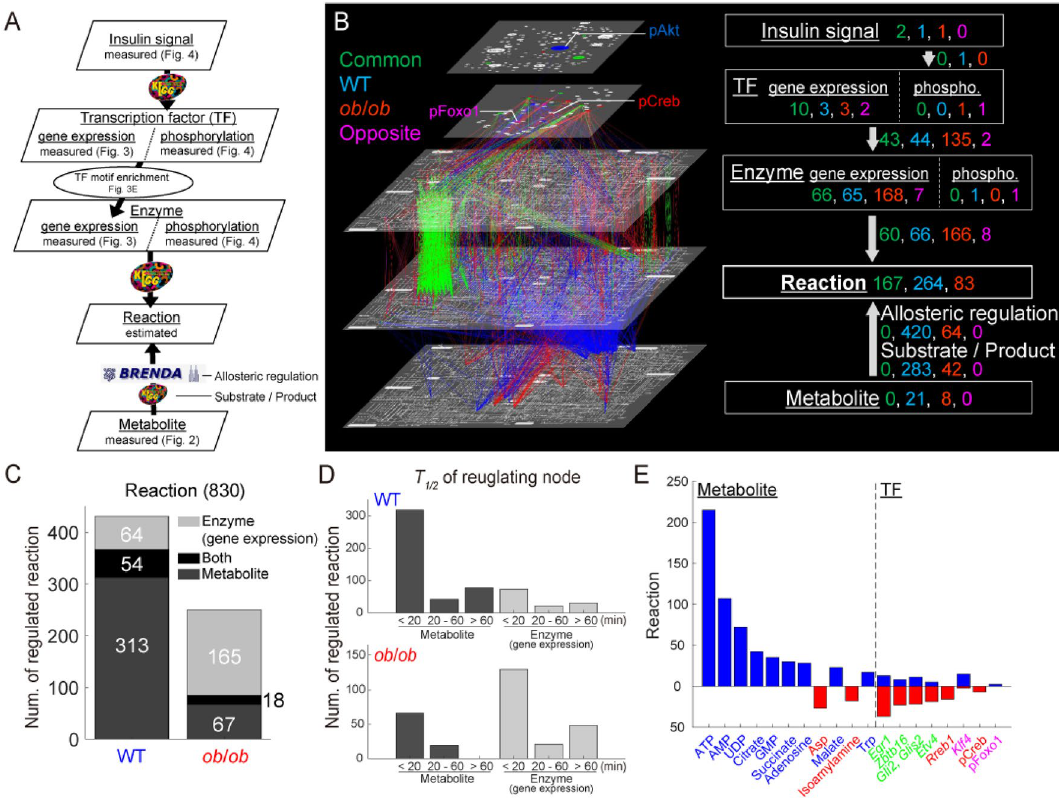
Figure 5. Construction of a regulatory transomic network for glucose-responsive metabolic reactions. ( A ) The procedure for constructing the regulatory transomic network for glucose-responsive metabolic reactions. The Insulin signal, TF, Enzyme, and Metabolite layers corresponded to glucose-responsive molecules. The Reaction layer represented “glucose-responsive metabolic reactions,” which were defined as metabolic reactions regulated by glucose-responsive molecules. The arrows indicate interlayer regulatory connections. The databases used to identify the interlayer regulatory connections are shown by arrows. ( B ) The regulatory transomic network for glucose-responsive metabolic reactions. The left diagram represents the network as colored nodes in the layers and edges between the layers with colored nodes representing glucose-responsive molecules and colored edges representing interlayer regulatory connections: green, glucose-responsive molecules and interlayer regulation common in both WT and ob / ob mice; blue, specific to WT mice; red, specific to ob / ob mice; pink, opposite responses between WT and ob / ob mice. The numbers of each type of glucose-responsive node and edge are shown in the same colors in the network summary to the right. The Insulin signal layer was the insulin signaling pathway constructed in our previous phosphoproteomic study 11 . The Enzyme, Reaction, and Metabolite layers were organized into global metabolic pathways (mmu01100) in the KEGG database 18,19 . Phospho, phosphorylated. ( C ) The number of glucose-responsive metabolic reactions regulated by glucose-responsive molecules in the Enzyme layer, Metabolite layer, or both from a total of 830 metabolic reactions in the skeletal muscle. ( D ) The number of glucose-responsive metabolic reactions regulated by glucose-responsive metabolites and genes with the indicated time constants T 1 / 2 in WT mice (upper) and ob / ob mice (lower). ( E ) The number of glucose-responsive metabolic reactions regulated by the indicated glucose-responsive molecules in WT mice (upper, blue) and ob / ob mice (lower, red). The colors of the names of molecules indicate the type of glucose- responsive molecules as described in ( B ). Glucose-responsive metabolites and transcriptions factors that regulated more than 15 metabolic reactions are shown. The transcription factors encoded by glucose-responsive genes are italicized, and those showing glucose-responsive phosphorylation have the prefix